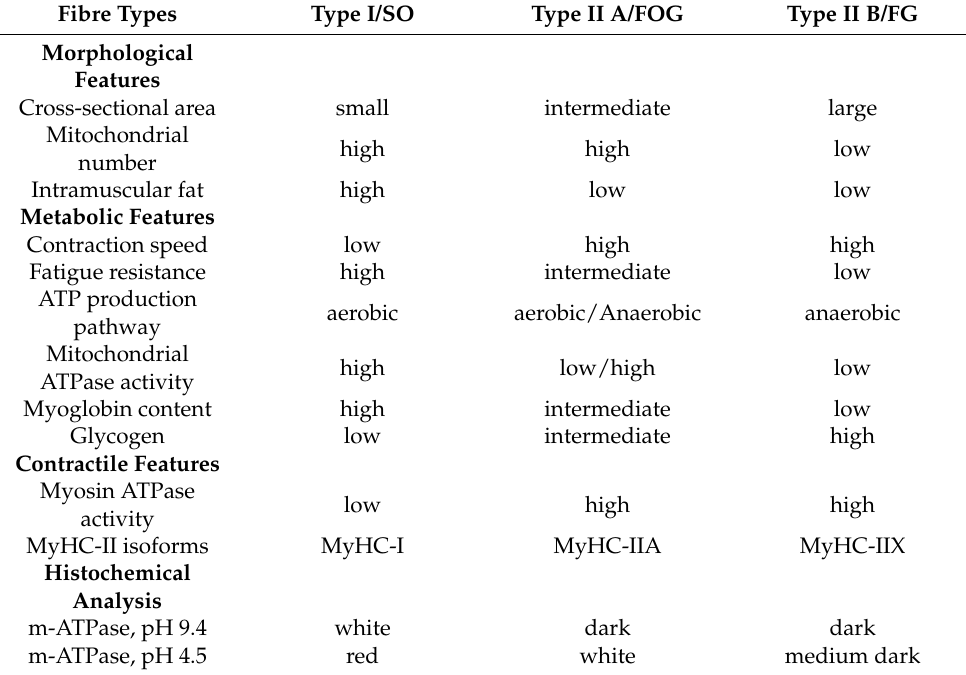
Table 1. Main morphological, metabolic, and histochemical features of muscle fibre [1,4,6] 1 . Fibre